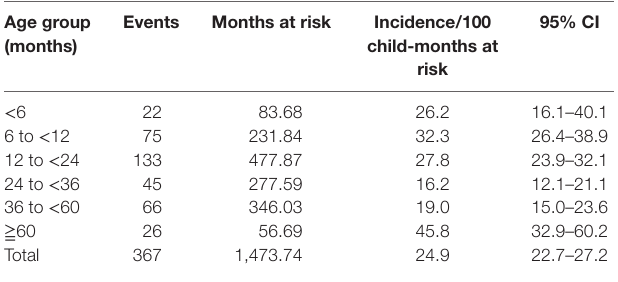
TaBle 1 | Incidence of ARIwC over 12 months in children aged less than 5 years from an urban, disadvantaged community, by age-group for time at risk. age group